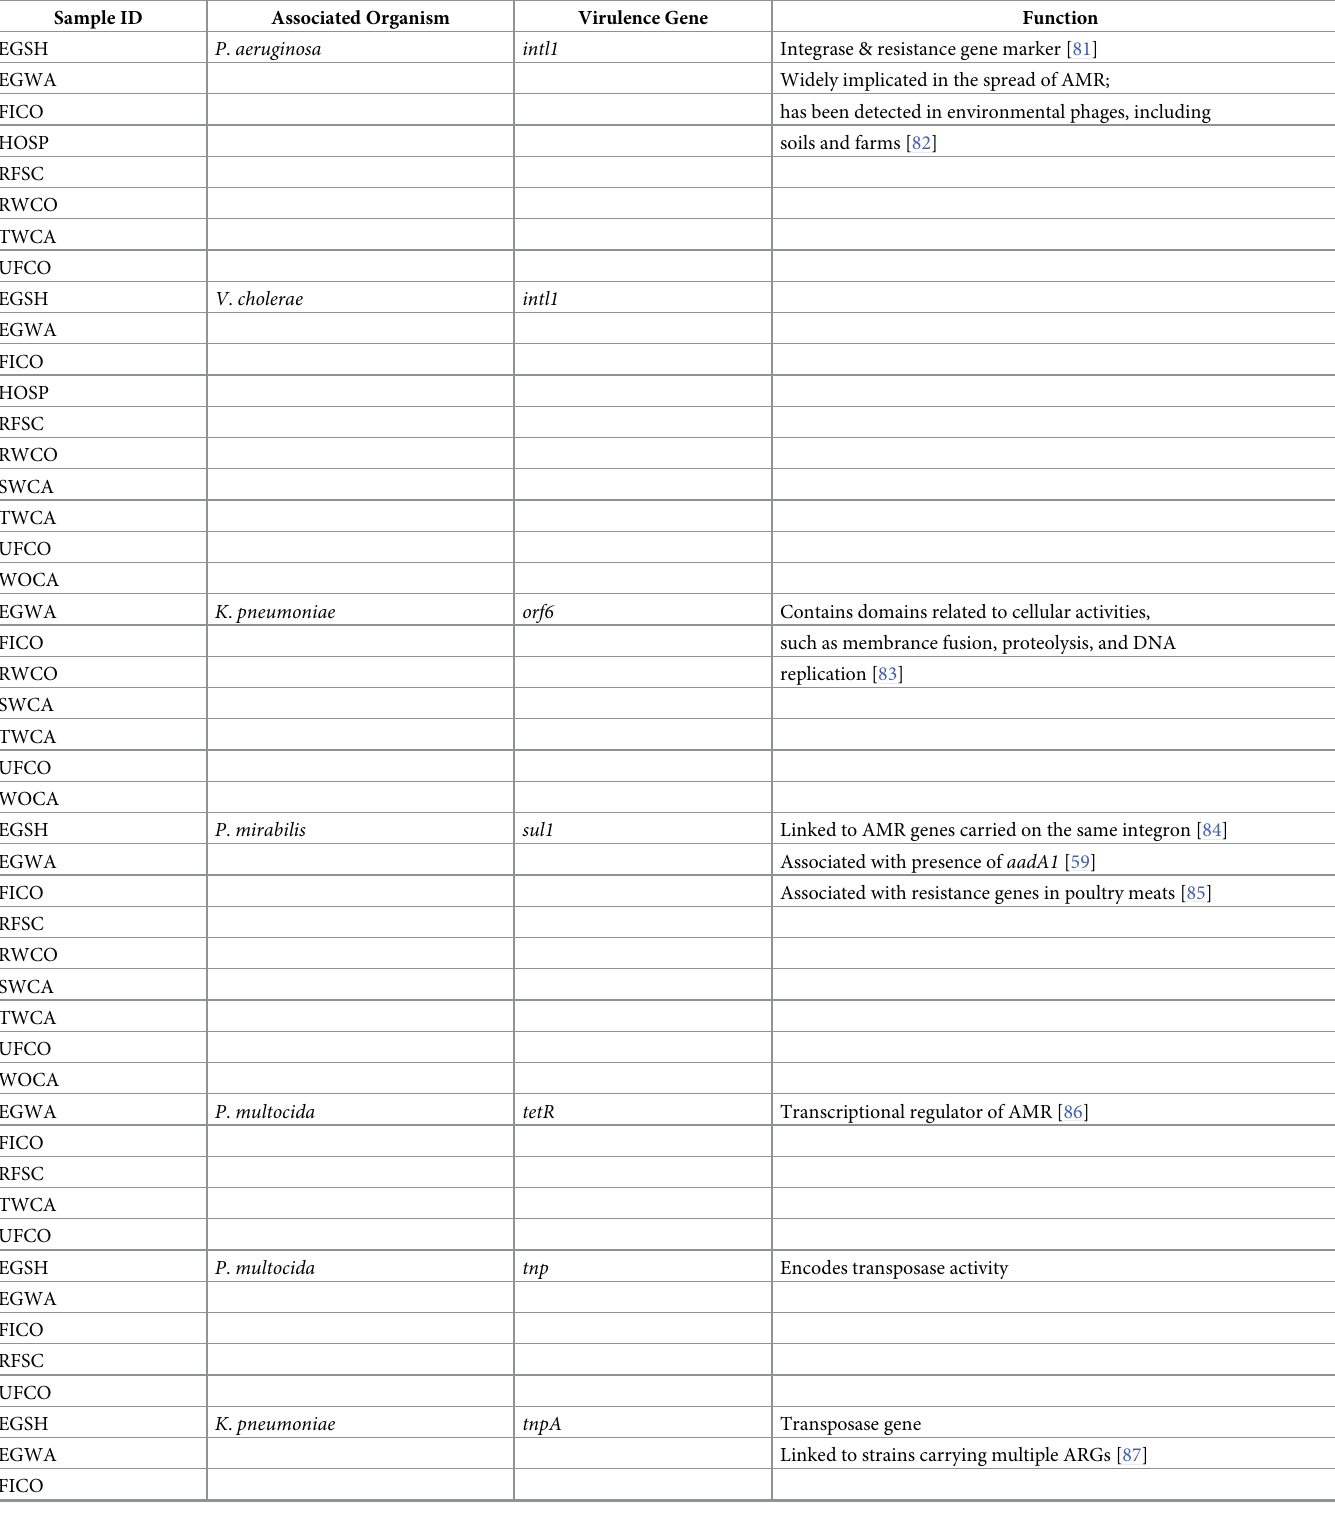
Table 3. Selected virulence genes, function, associated organism and